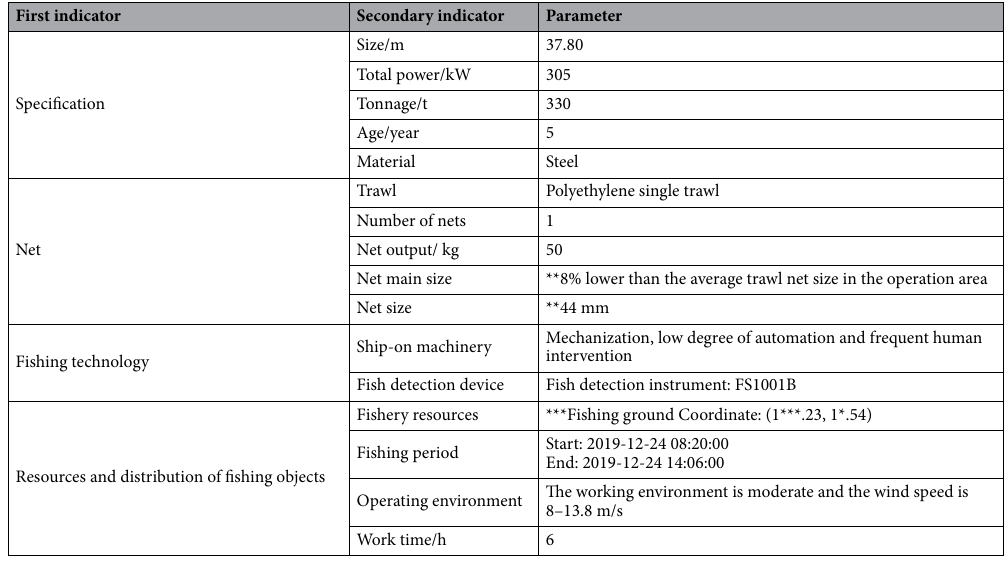
Table 2. Fishing vessels indicator information.